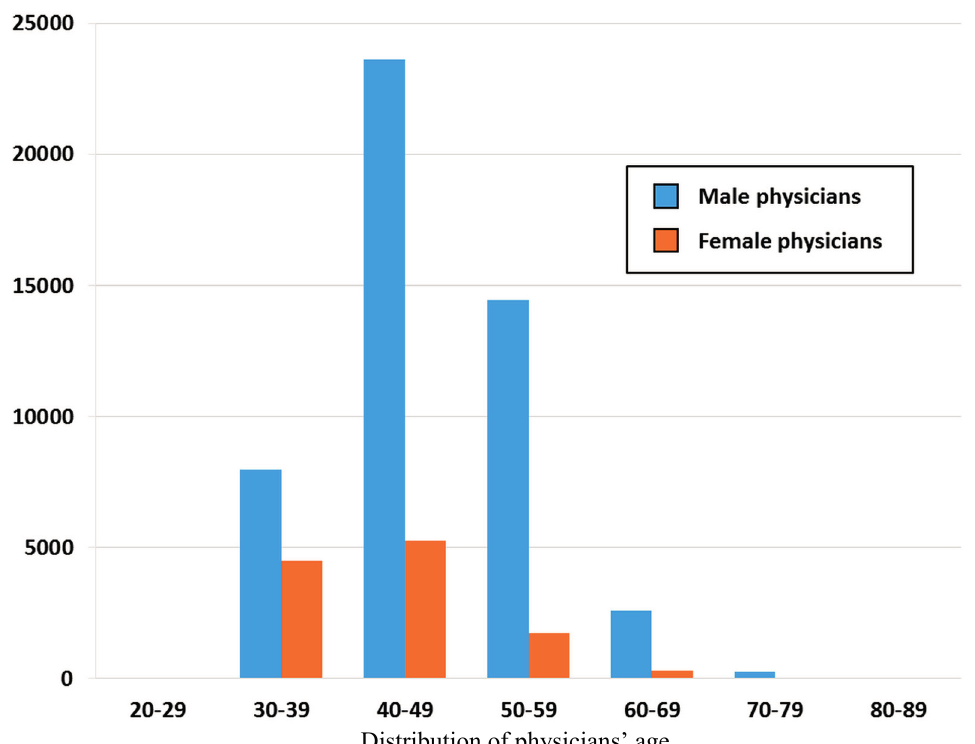
Figure 2. Age and sex distribution of pediatricians, data from Taiwan’s National Health Insurance in 2012 (sampling rate: 1/500).